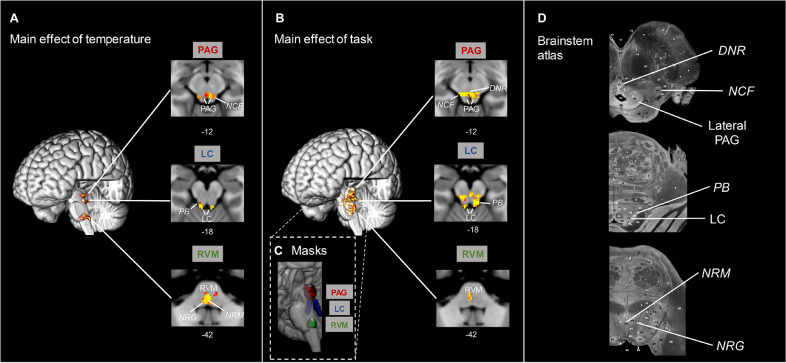
Main effect analyses in the brainstem. Results obtained after permutation testing with a probabilistic whole brainstem mask (p < 0.05, TFCE corrected).(A)Clusters of activation in the brainstem corresponding to the main effect oftemperatureincluded the ventral and lateral periaqueductal grey (PAG), rostral ventromedial medulla (RVM), including nucleus raphe magnus (NRM) and nucleus reticularis gigantocellularis (NRG), bilateral locus coeruleus (LC) which were all localised using the masks in (C) and activation was also noted in the region of the dorsal nucleus of raphe (DNR), nucleus reticularis cuneiformis (NCF) and parabrachial nucleus (PB) identified by comparison with the Duvernoy brainstem atlas (Naidich et al., 2009).(B)Extensive brainstem activity was observed in the main effect oftask, including the PAG, RVM (to a lesser extent than fortemperature), bilateral LC (all localised using regional masks), as well as activity in the region of DNR, NCF and PB.(C)Shows the position and extent of the anatomical masks defined in (Brooks et al., 2017) used to confirm the localisation of activity in the PAG (red), LC (blue), RVM (green).(D)shows comparative MR microscopy sections from the Duvernoy brainstem atlas (reproduced with permission), modified to highlight activity identified by reference to the atlas (shown in italics).